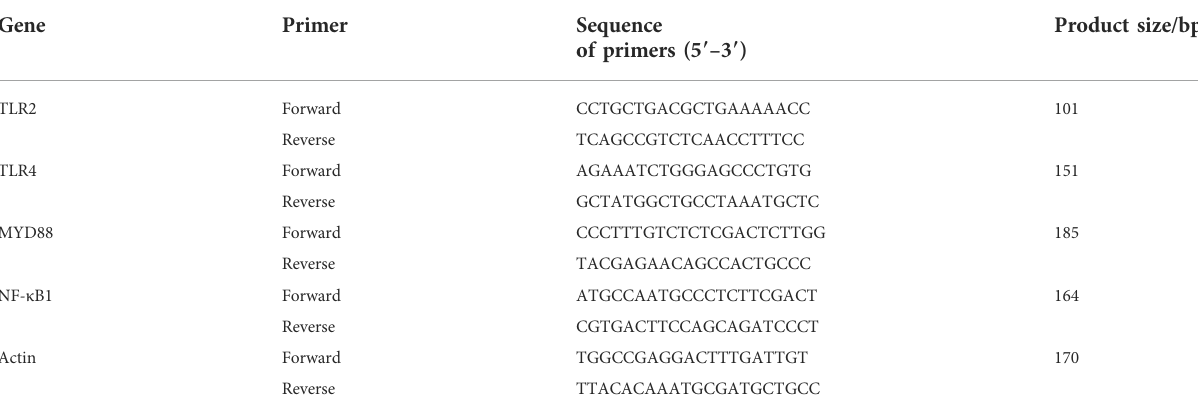
TABLE 2 Sequences of primers used in the